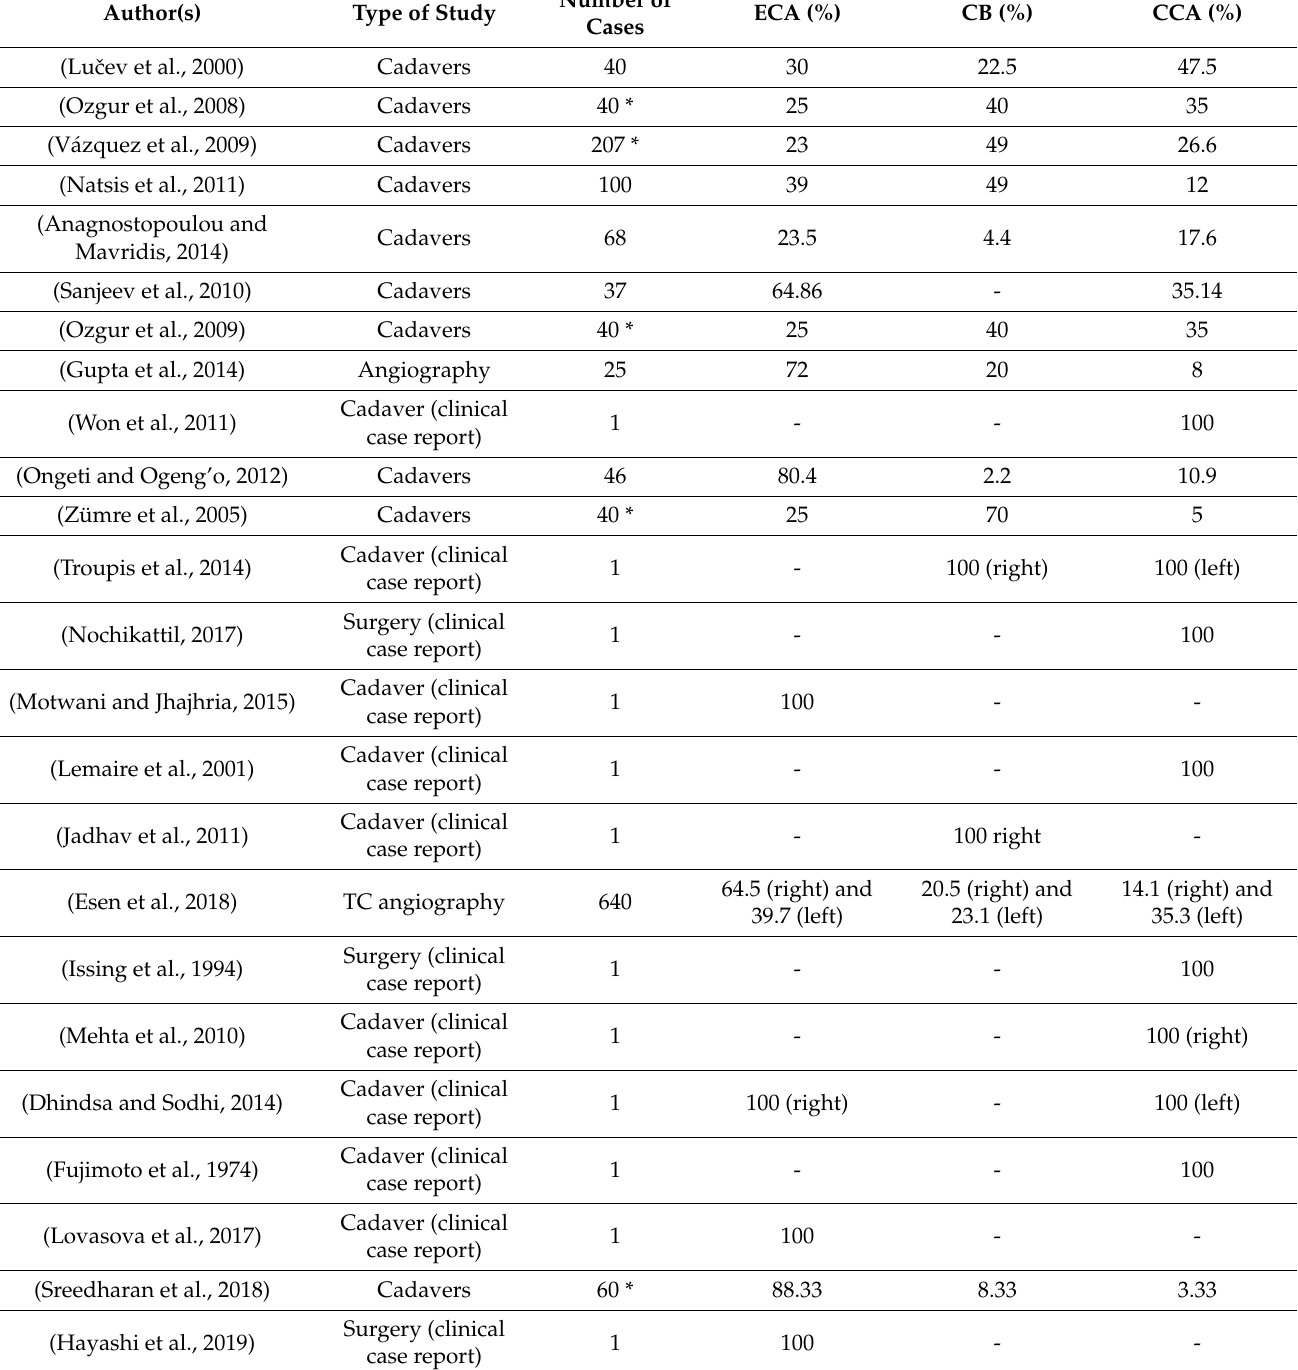
Table 1. Available data concerning STA